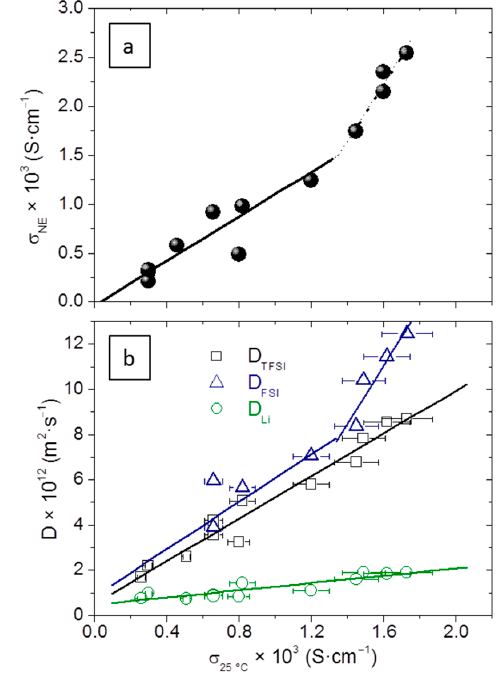
Figure 6. ( a ) Relationship between experimental σ at 25 °C and that obtained by the Nernst–Einstein equation ( σ NE ). ( b ) Relationship between D Li , D TFSI , D FSI , and experimental σ at 25 °C.